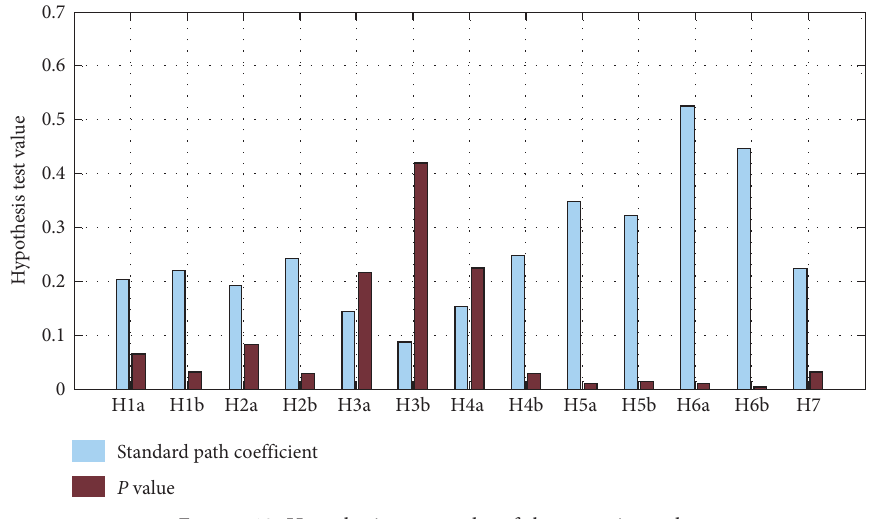
Figure 10: Hypothesis test results of the maturity